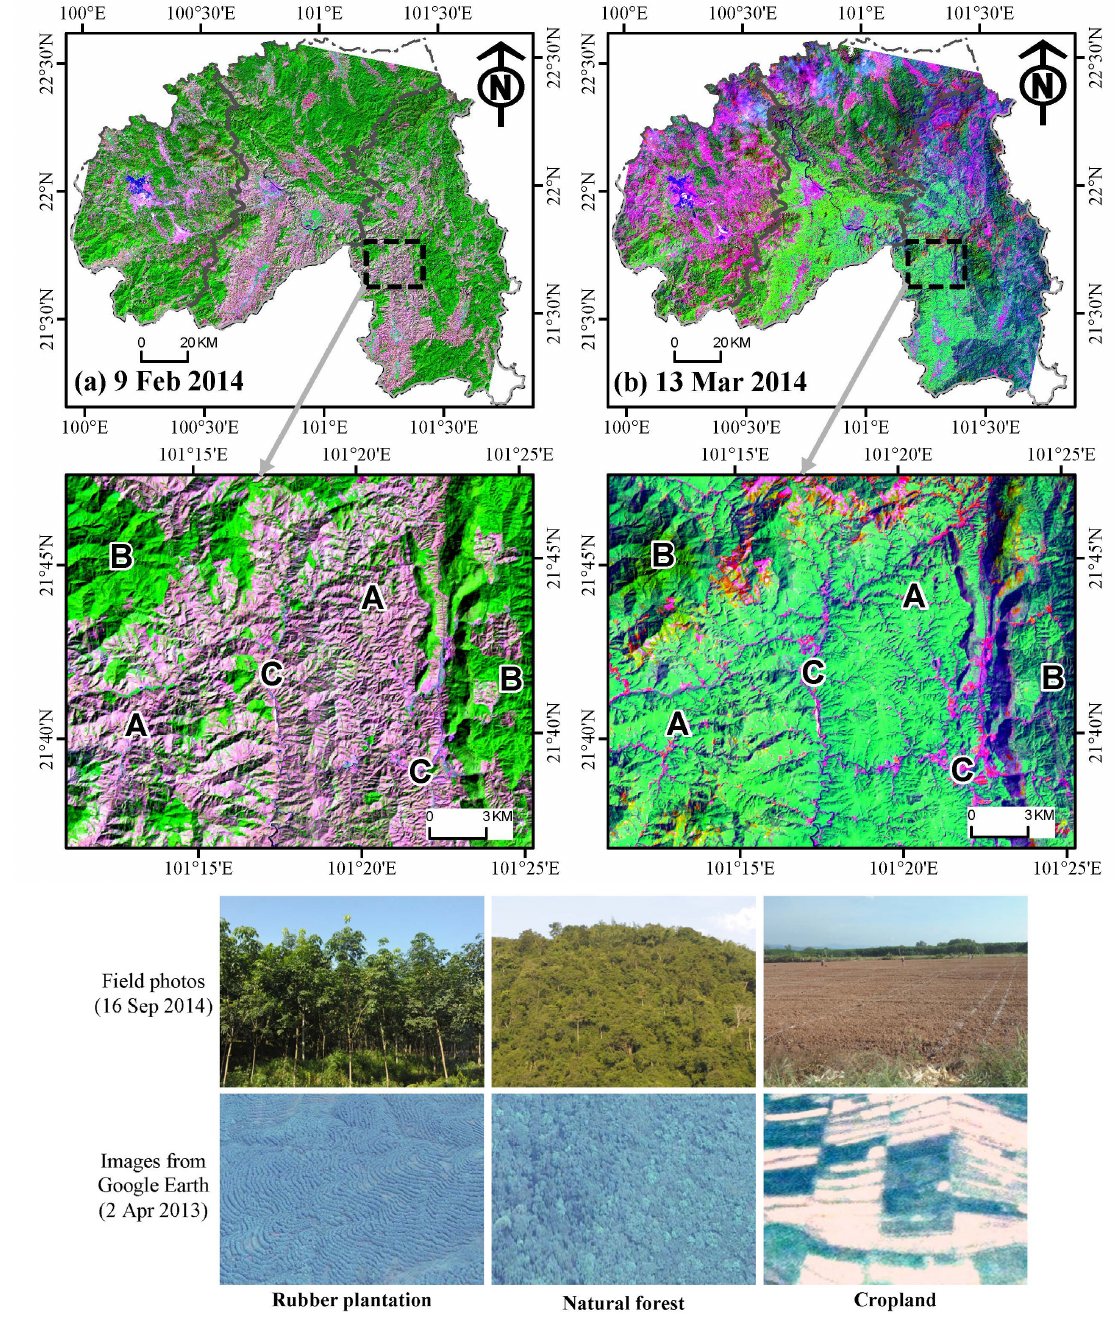
Figure 3. The false colour composition map (R/G/B = Band 7/5/4) of the Landsat 8 OLI images, including ( a ) the image during the nearly complete defoliation stage of the rubber trees on 9 February 2014 and ( b ) the image during the full foliation stage of the rubber trees on 13 March 2014. The zoom-in images of a typical area show that the rubber plantations are easily discernible as greyish-purple patches in the defoliation stage in image ( a ) and as light green patches during the foliation stage in image ( b ). However, the natural forest is always green during the defoliation ( a ) and foliation ( b ) stages of rubber trees. Major land cover classes of interest were marked in the zoom-in images, including rubber plantation (“A”), natural forest (“B”), and cropland